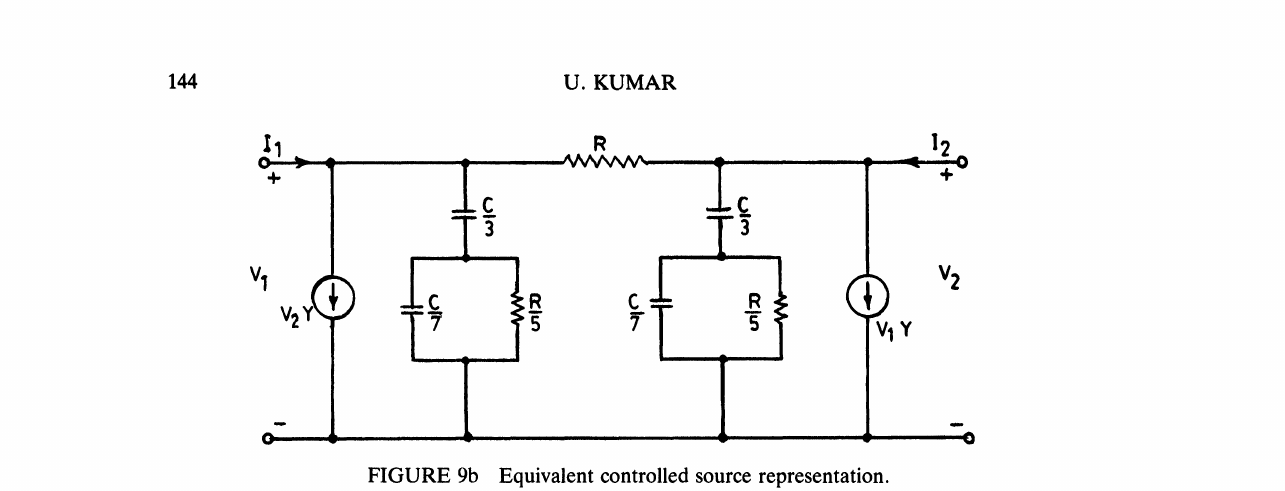
FIGURE 9b Equivalent controlled source